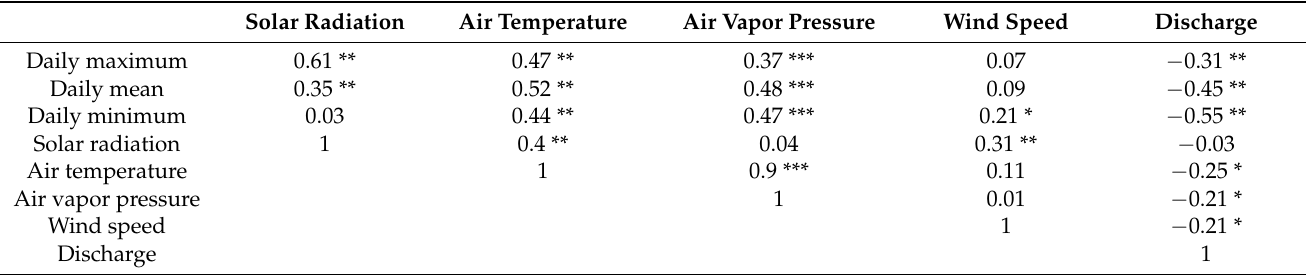
Table 4. Spearman rank correlation coefficients between treatment effects and hydrometeorological variables.